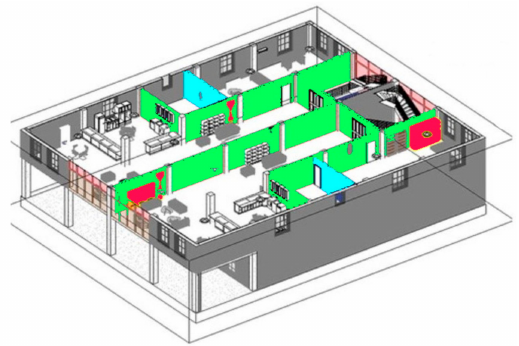
Figure 7. Color-coding of different ranges of seismic risk scores in a 3D digital model